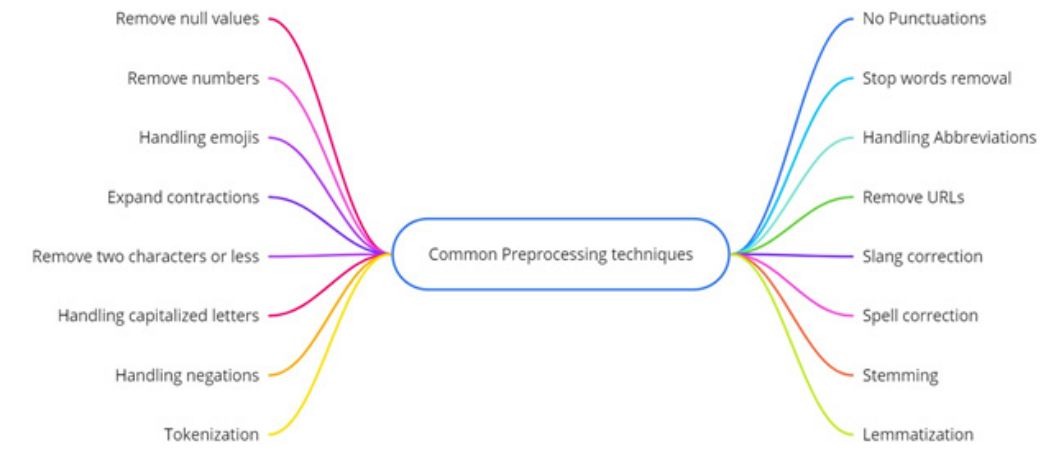
Figure 3. Common preprocessing techniques.